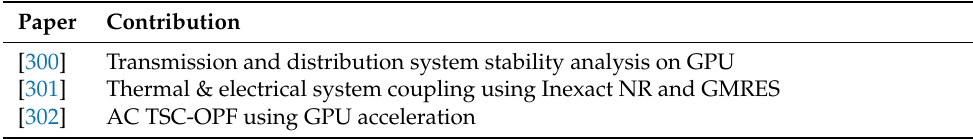
Table 10. Unique Formulations and Other MIMD-based state-of-the-art studies.